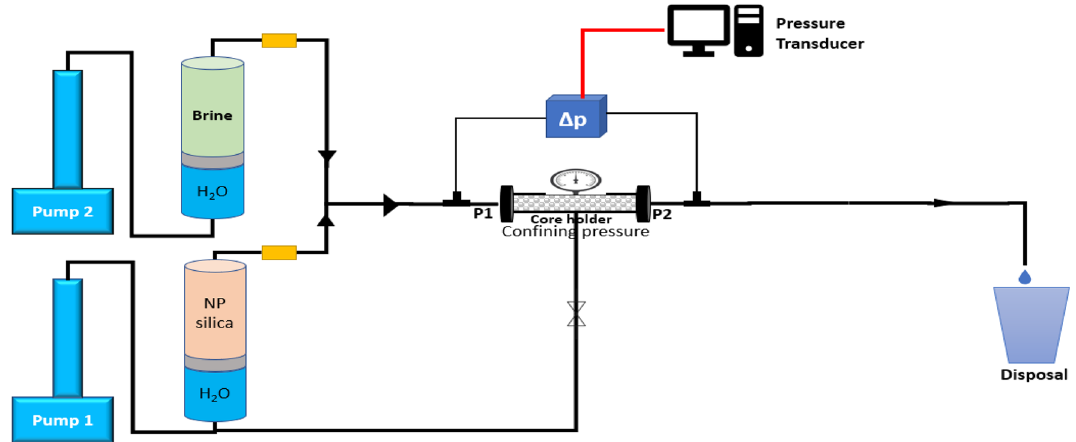
Fig. 3 Experimental set-up for the injectivity